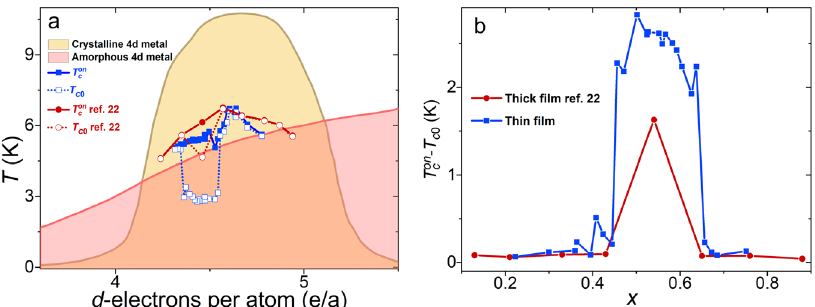
Fig. 3 Suppression of superconductivity in the near-equimolar region. a The valence-electron concentration dependence of the onset temperature and the zero-resistivity temperature of superconductivity. The valence-electron concentration as a function of composition is shown in the Supplementary information (Supplementary Fig. 4c). The black dashed line schematically shows the T c dependence of (TaNb) 1 − x (ZrHfTi) x crystalline fi lms on the valence- electron concentration. b The transition width between T on c and T c 0 as a function of ZrHfTi